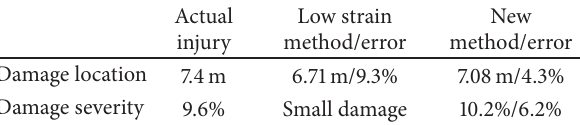
Table 2: Results of damage